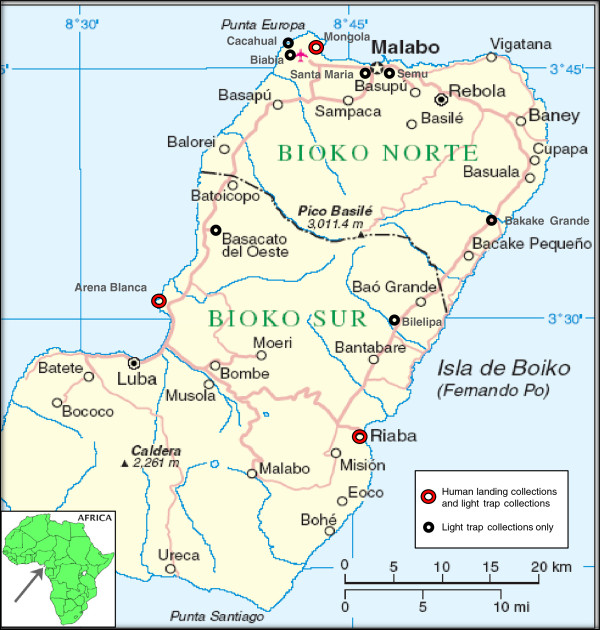
Mosquito collection sites of the Bioko Island Malaria Control Project, Bioko Island, Equatorial Guinea. The three sites in the Punta Europa area together make up the Punta Europa sentinel site. Arena Blanca is not part of the original sentinel sites, but was added as a mosquito collection site in 2009. (Source: Map No. 3861 Rev. 4, January 2005, Department of Peacekeeping Operations Cartographic Section, United Nations.
http://www.un.org/Depts/Cartographic/map/profile/eqguinea.pdf.).